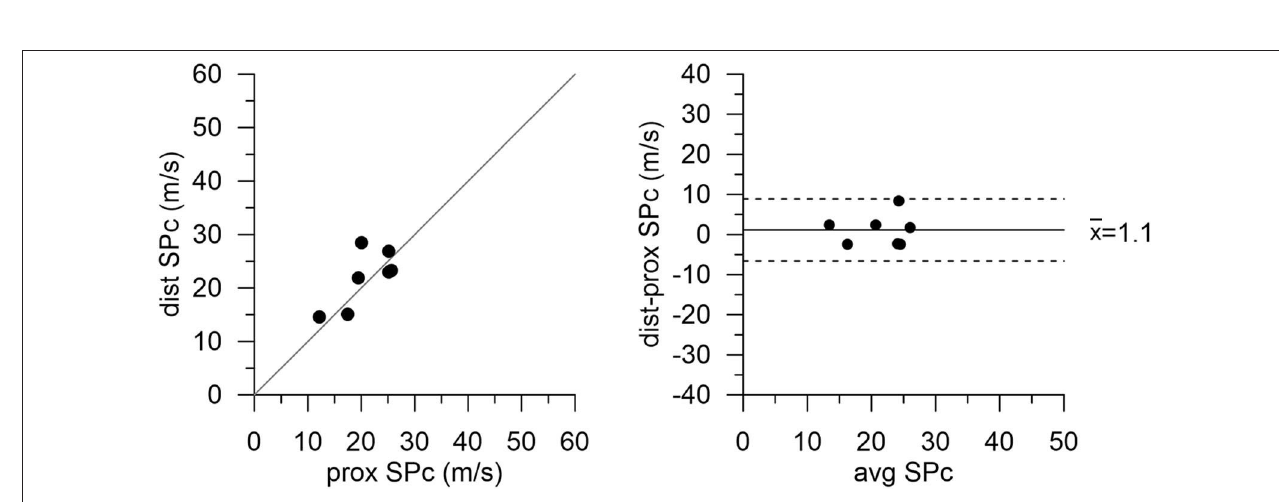
FIGURE 4 | Wave speed (SPc) in diseased vessels at proximal and distal locations after PCI with stent placement. Agreement between measurement locations is close. Note: proximal values are pre-PCI data in this subgroup of patients.